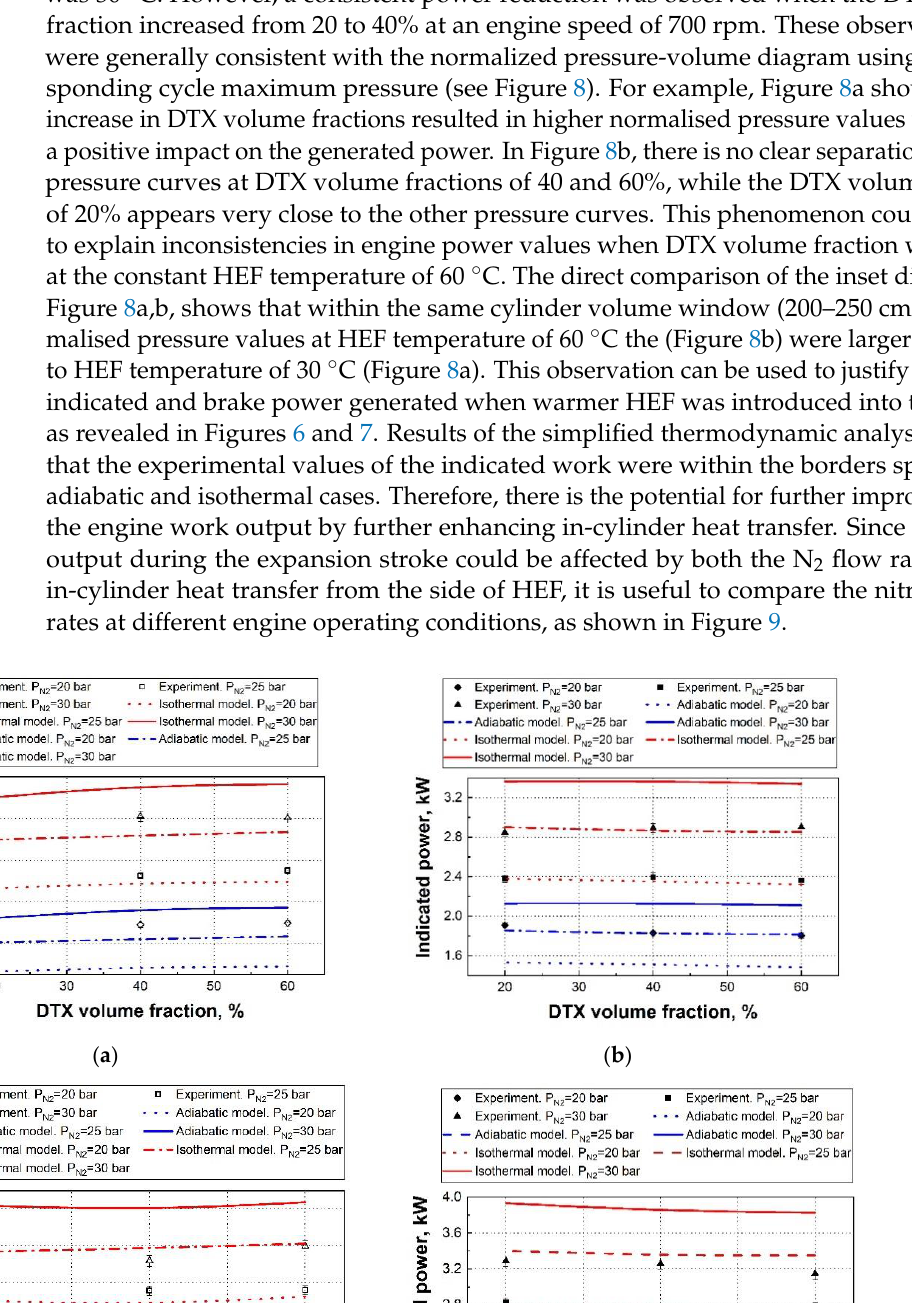
( b ) Figure 7. Brake power at different engine speeds: ( a ) 𝑁 = 600 rpm and ( b ) 𝑁 = 700 rpm . ( a ) ( b ) Figure 8. Comparison of normalised pressure-volume diagrams for different DTX concentrations at the engine speed of 600 rpm (corresponding to the 25 bar curve): ( a ) HEF temperature 30 °C, ( b ) HEF temperature 60 °C. Figure 9 shows that the N 2 consumption rates were generally increased when the DTX volume fraction increased at the HEF temperature of 30 °C. At higher DTX volume